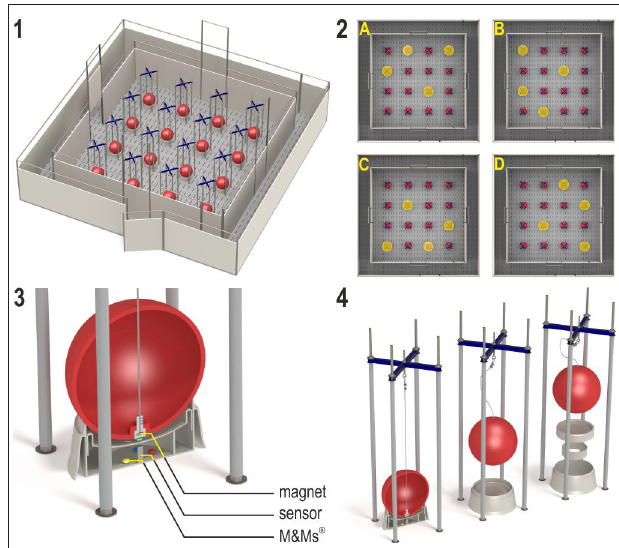
FIGURE 2 | (1) The spatial cognitive holeboard for pigs. (2) The four patterns of baited holes. (3) , (4) Constructional details of the holes. Each hole—a fool bowl with a false bottom under which three M&M’s ® chocolates are placed in order to mask odor cues—is covered by a red ball. Each food bowl is equipped with a sensor that sends a signal to the computer if the contact between the magnet in the ball is interrupted; i.e., when the pig lifts the ball with its snout (illustrations: Yorrit van der